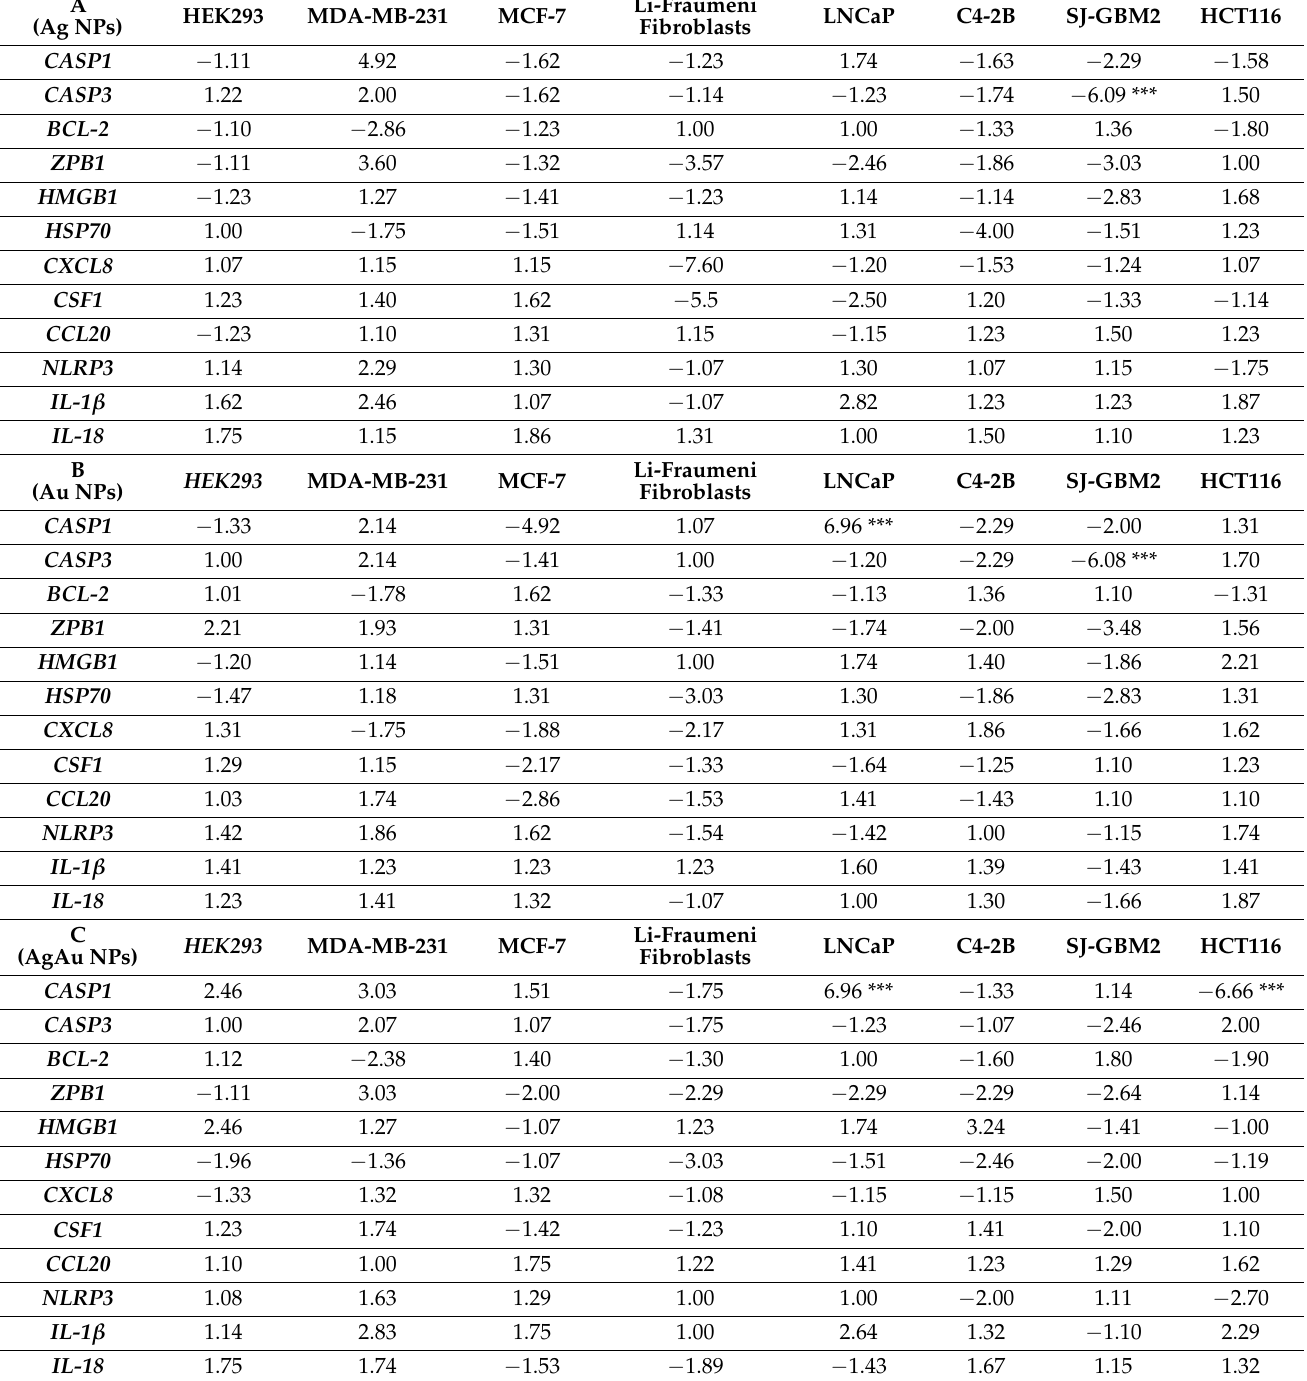
Table 2. mRNA fold changes in AU after incubation with Ag NPs ( A ). Au NPs ( B ) and AgAu NPs ( C ). The asterisk (***) shows statistical significance ( p < 0.05) compared to untreated